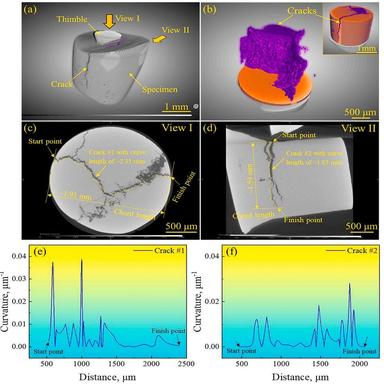
Three-dimension characterization of the LME cracks: (a) 3D views of the specimen, (b) 3D morphology of the crack in the specimen, (c) the crack morphology in view I, (d) the crack morphology in view II, (e) the curvature of the crack #1 indicated in (c), and (f) the curvature of the crack #1 indicated in (d).